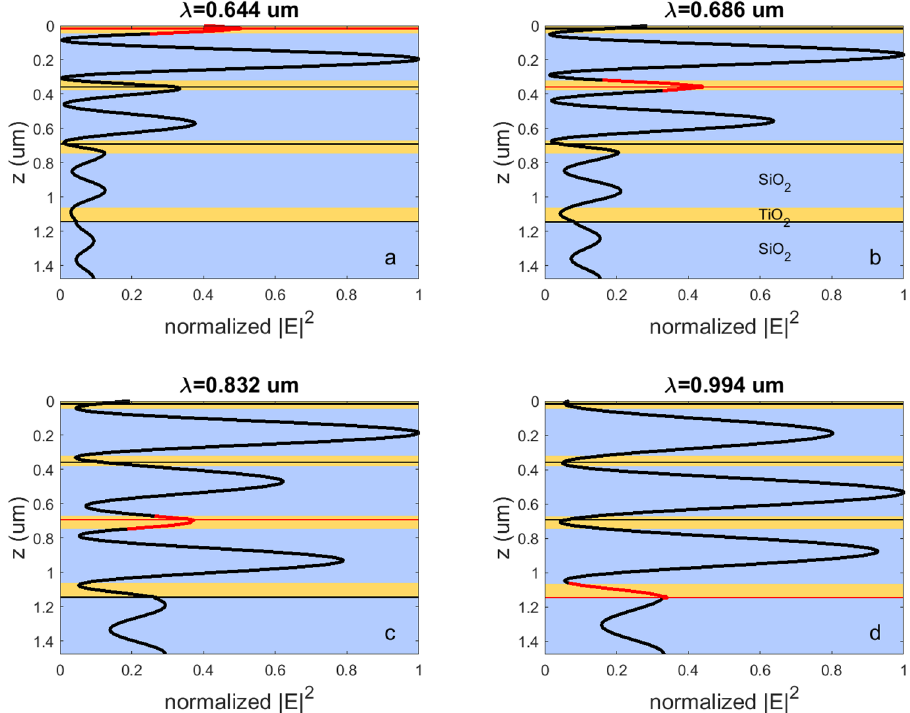
Figure 4. The spatial distribution of the normalized |E| 2 in the chirped MPC with the patterned GdFeCo layer at the ‘operating’ wavelengths of ( a ) 644 nm, ( b ) 686 nm, ( c ) 832 nm, ( d ) 994 nm. Red sections of the curve show the magnitude of the normalized |E| 2 inside the addressed GdFeCo layer and nearby. As in the Fig. 3 the yellow areas correspond to TiO 2 layers, the blue regions refer to SiO 2 layers, and the red and black lines indicate the position of the 9 nm-thick patterned GdFeCo layers. The red ones denote the position of the remagnetized layers, and the black ones refer to the GdFeCo layers with untouched magnetization.